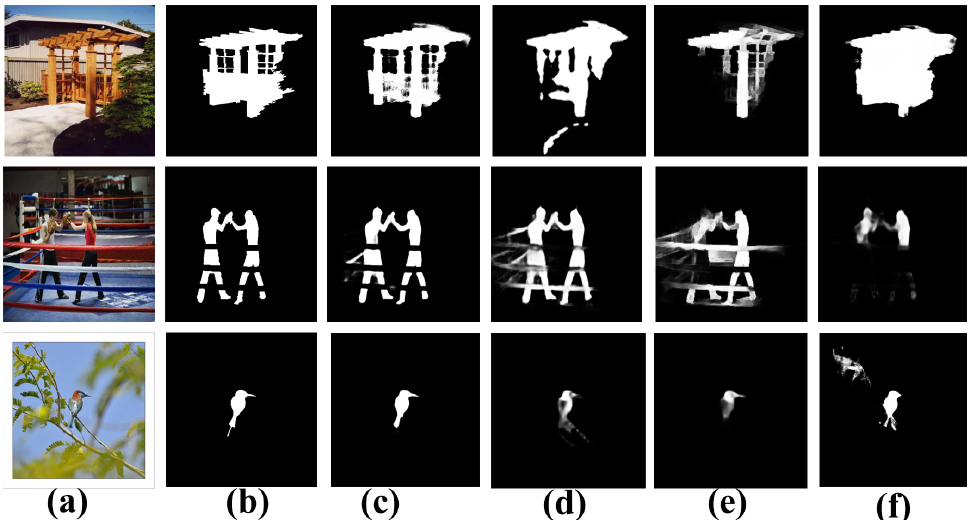
Figure 1. Sample comparisons of our method with others. From left to right: ( a ) input image, ( b ) ground truth, ( c ) saliency map of our approach, ( d ) saliency map of CPD [21], ( e ) saliency map of AFNet [22], and ( f ) saliency map of R3Net [23]. Our method generates more rigorous saliency maps with defined